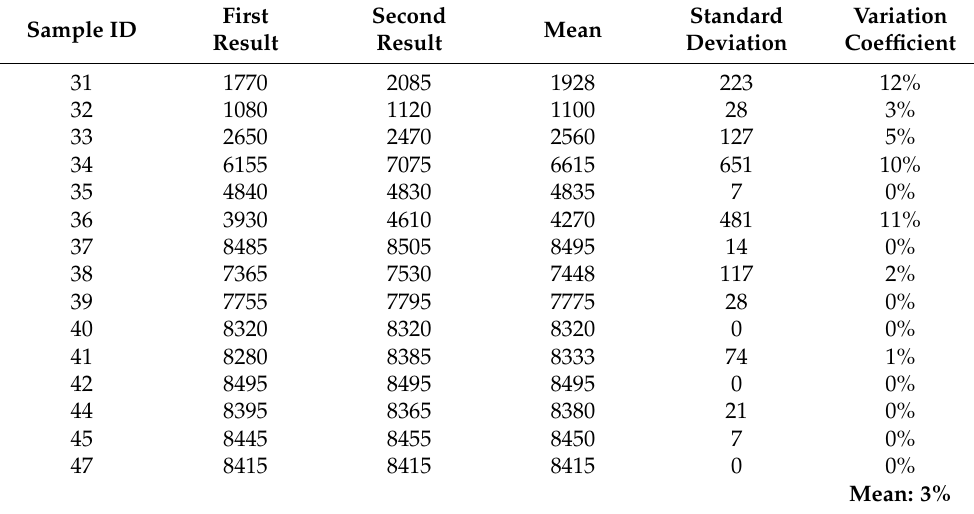
Table 2. Repeatability data. Samples were assessed in duplicate by the BacterisK assay to determine the repeatability. Global variation coefficient, obtained from the means of all variation coefficients ( n = 15), is equal to